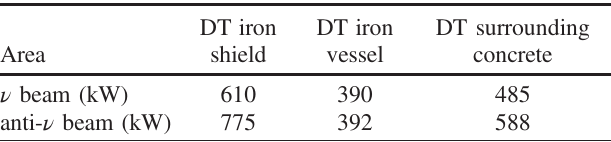
TABLE VII. Total energy deposition in kW for the graphite beam dump and various shields.